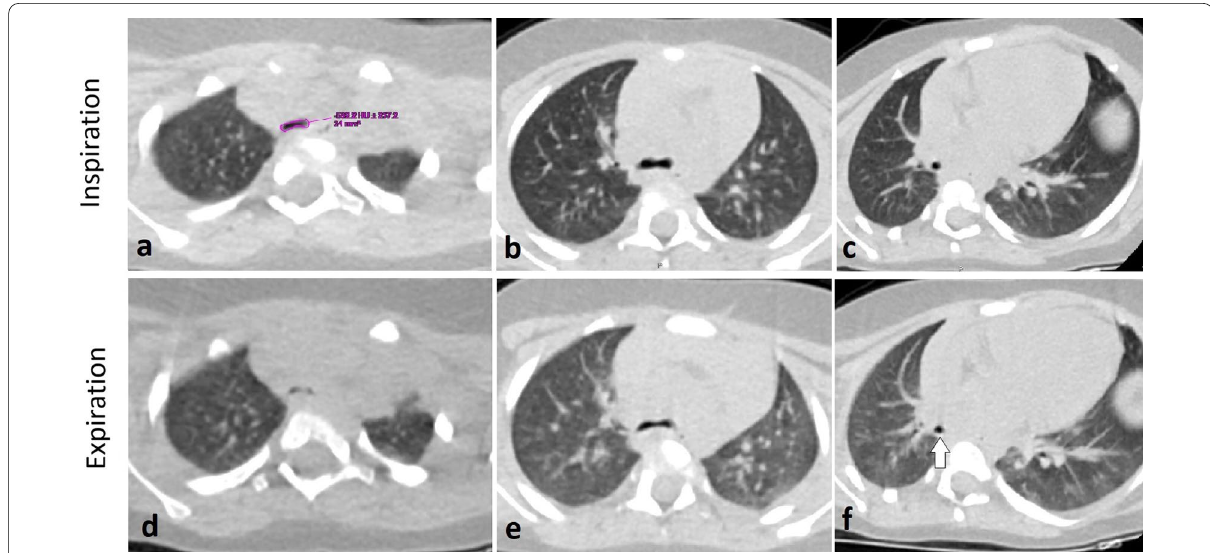
Fig. 2 Different degrees of expiratory central airway collapse perceived by cine CT at different airway levels. Free-breathing cine CT images obtained at end-inspiratory and end-expiratory phases revealed class 3 ( ( 50–70%) airway collapse at carina level ( b , e ) and class 1 (< 50%) airway collapse at bronchus intermedius level ( c , f ). At bronchus intermedius ≥ level, mild airway collapse is diagnosed by flattening of its posterior wall during expiratory phase (arrow)